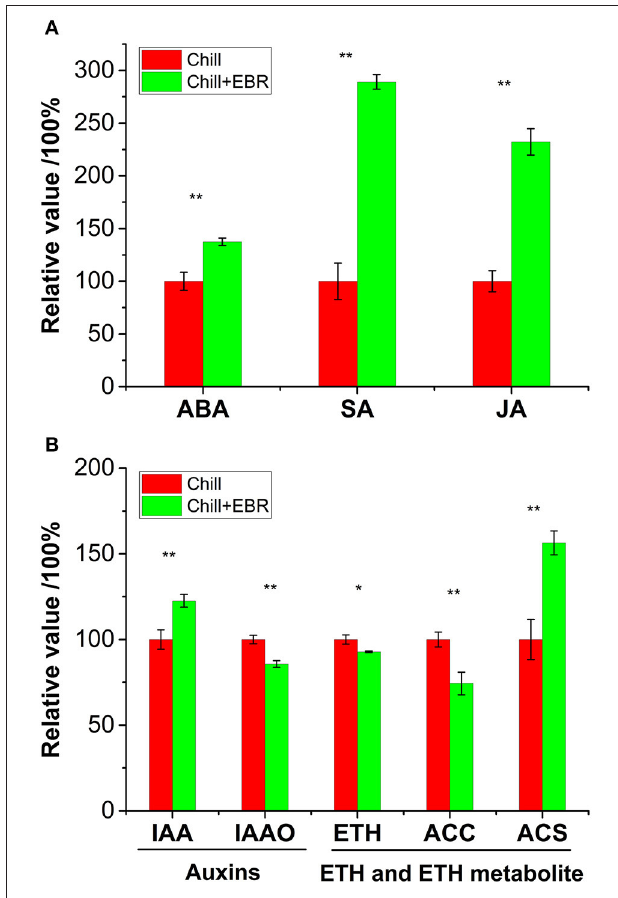
FIGURE 6 | Endogenous hormone profiles of pepper seedlings grown in the only chill stress (Chill) or chill stress with 0.1 µ M EBR (Chill + EBR). (A) Contents of ABA, SA and JA in leaves of pepper seedlings. (B) Contents and metabolites of IAA and ETH in leaves of pepper seedlings. Error bars represent the standard error (SE) of the mean for three replicates. Asterisks above the histograms indicated significant differences between Chill and Chill + EBT by Student’s t- test (** P < 0.01; * P <